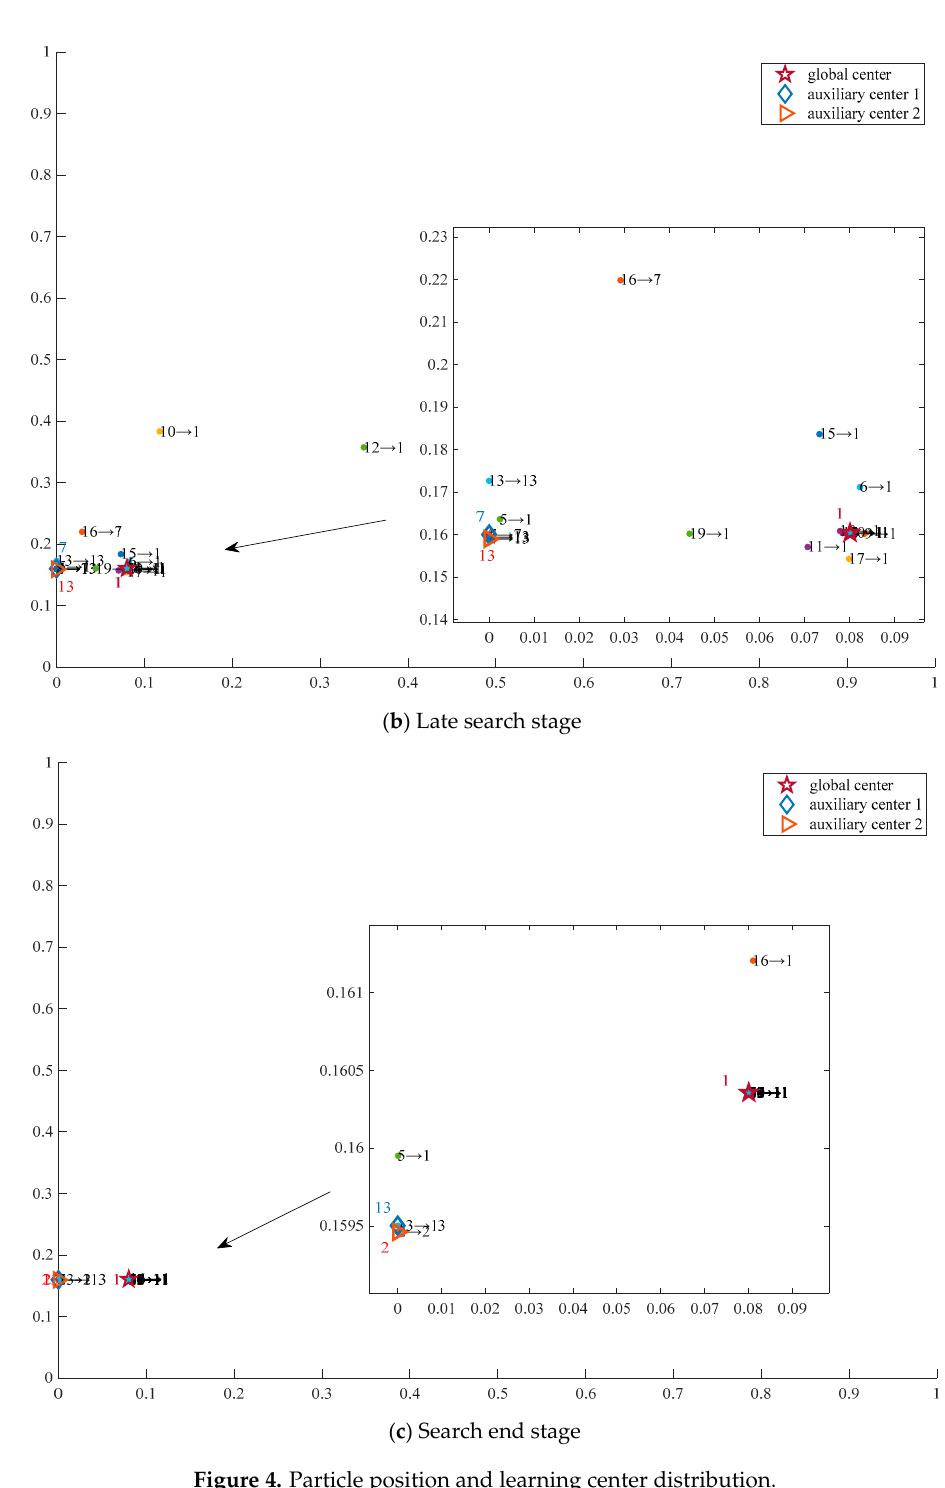
Figure 4. Particle position and learning center distribution.